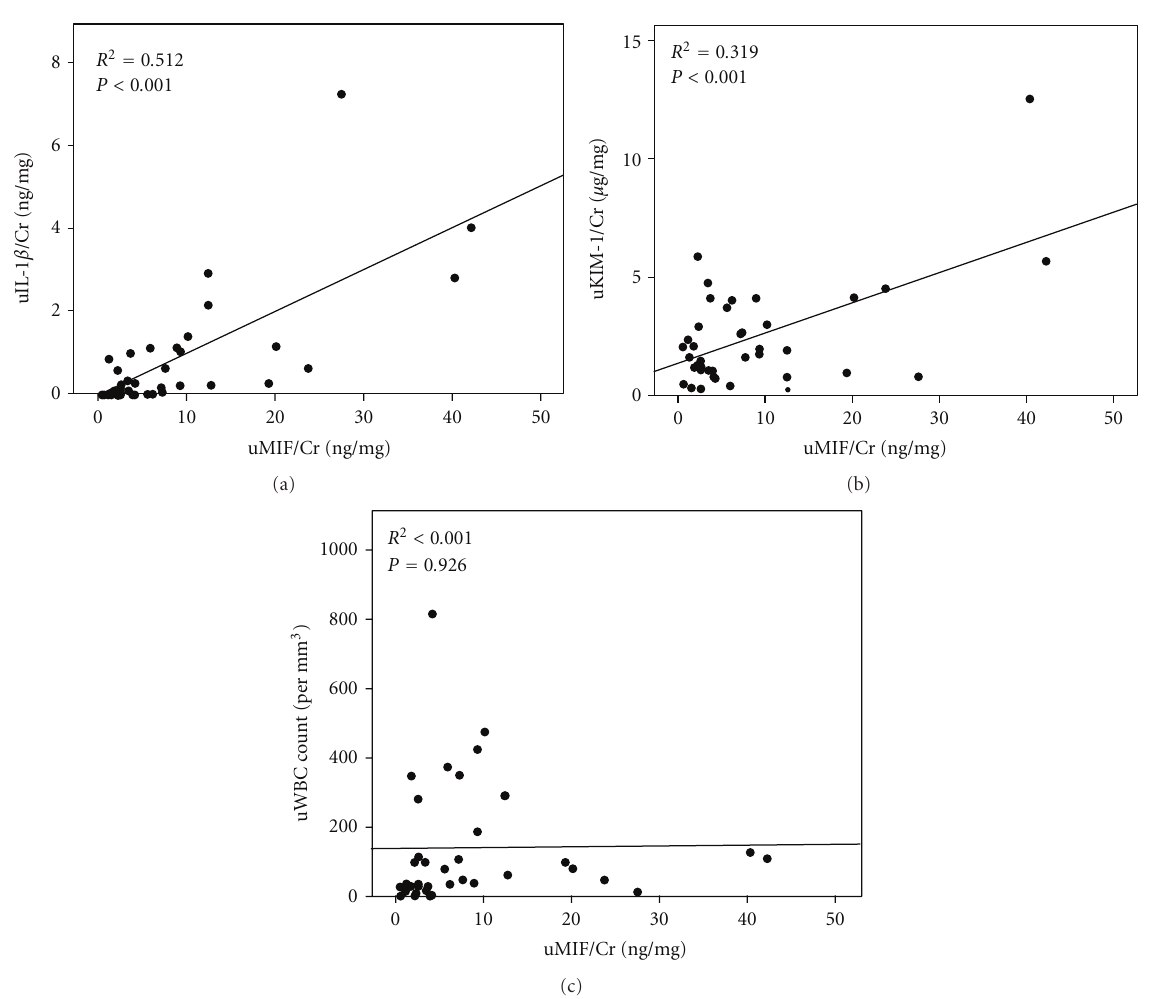
Figure 2: The pairwise correlations between the urinary levels of MIF (uMIF/Cr) and the urinary level of IL-1 β (uIL-1 β /Cr), the urinary level of KIM-1 (uKIM-1/Cr) and the urinary WBC (uWBC) count. Pearson correlation coe ffi cients were used to analyze the correlation between two variables. Each circle represents a single individual, and lines represent linear